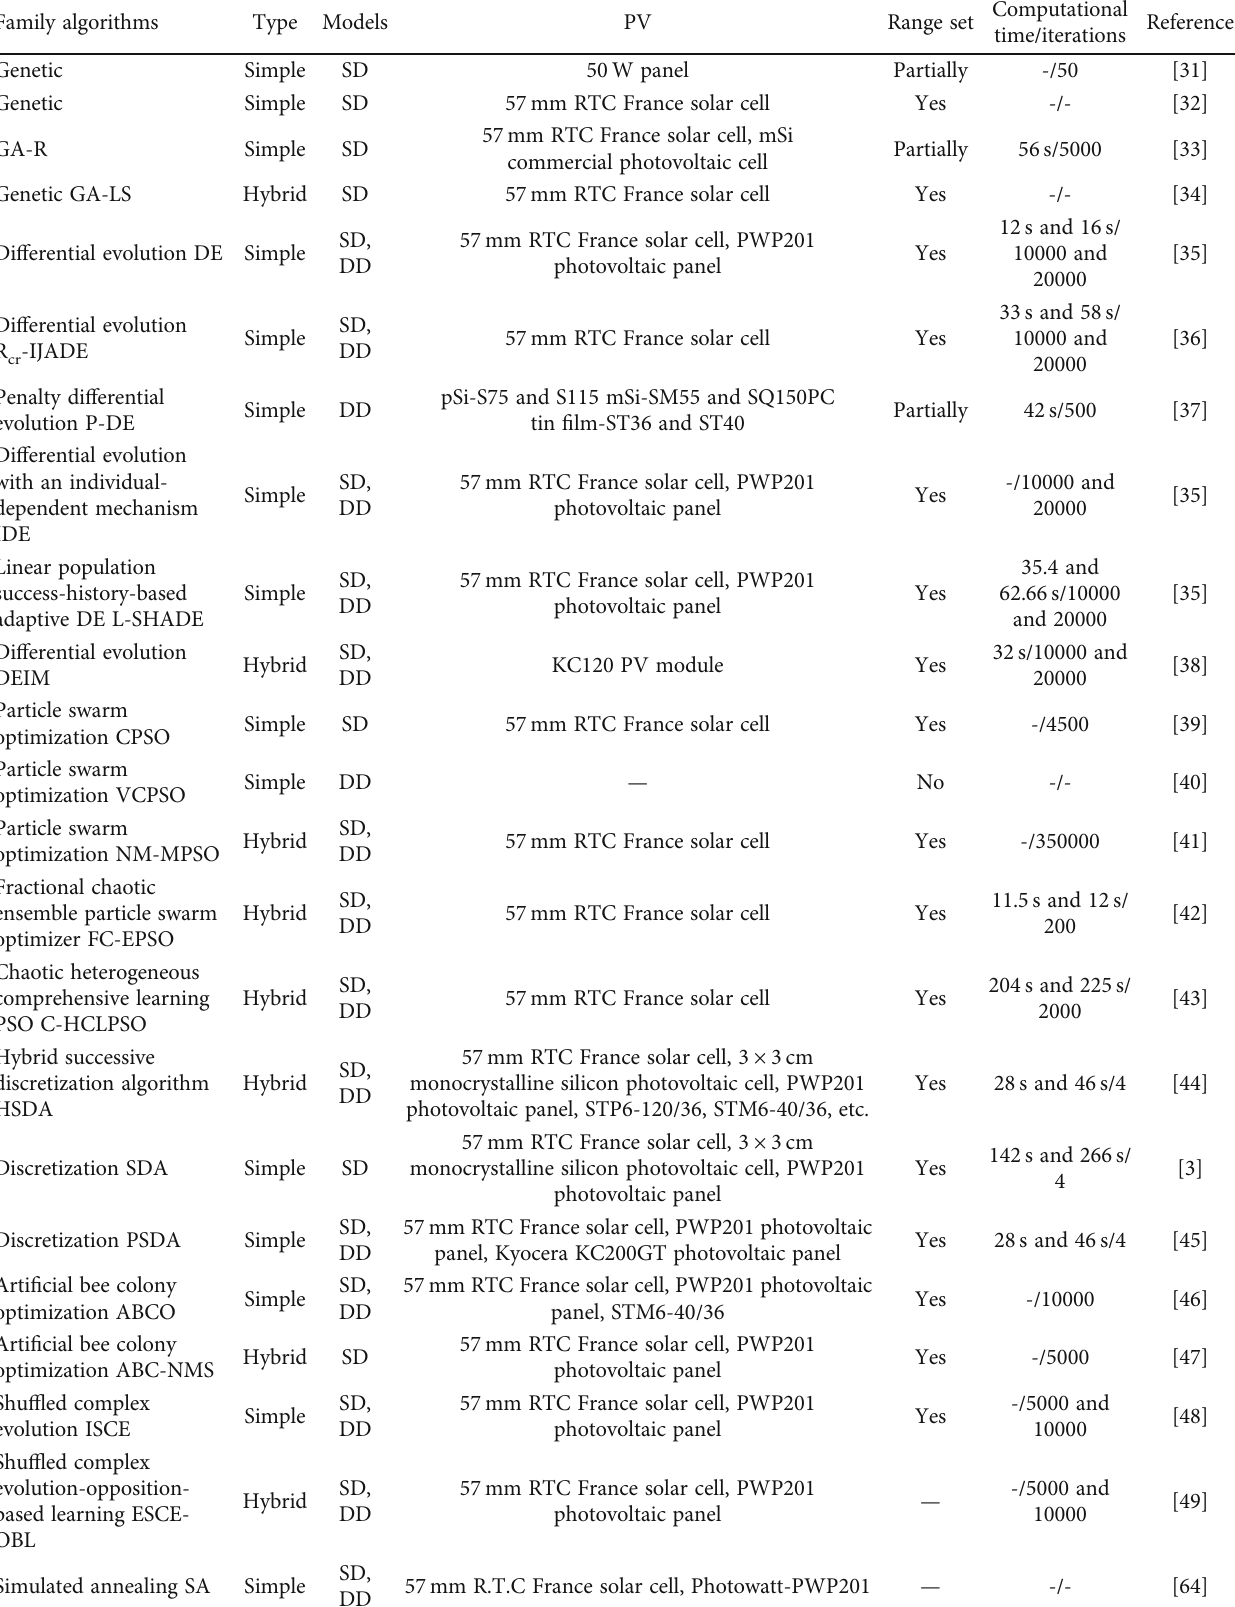
Table 2: The metaheuristic